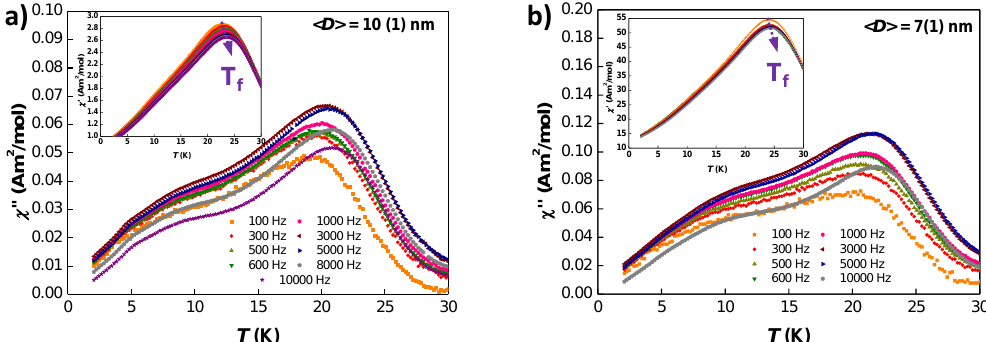
Figure 7. Imaginary χ (cid:48)(cid:48) ( T , f ) component of the AC-susceptibility measured for ( a ) (cid:104) D (cid:105) = 10 ( 1 ) nm and ( b ) (cid:104) D (cid:105) = 7(1) nm GdCu 2 NPs. The insets show the real χ (cid:48) ( T , f ) component, where the position of T f is marked by a purple